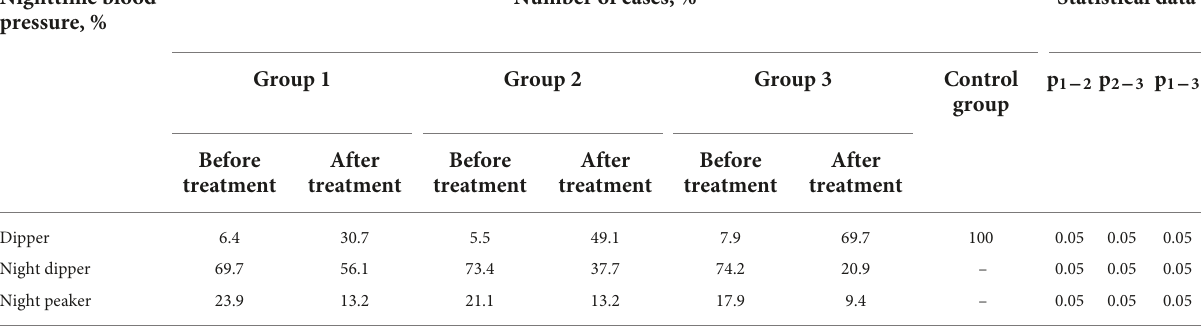
After treatment